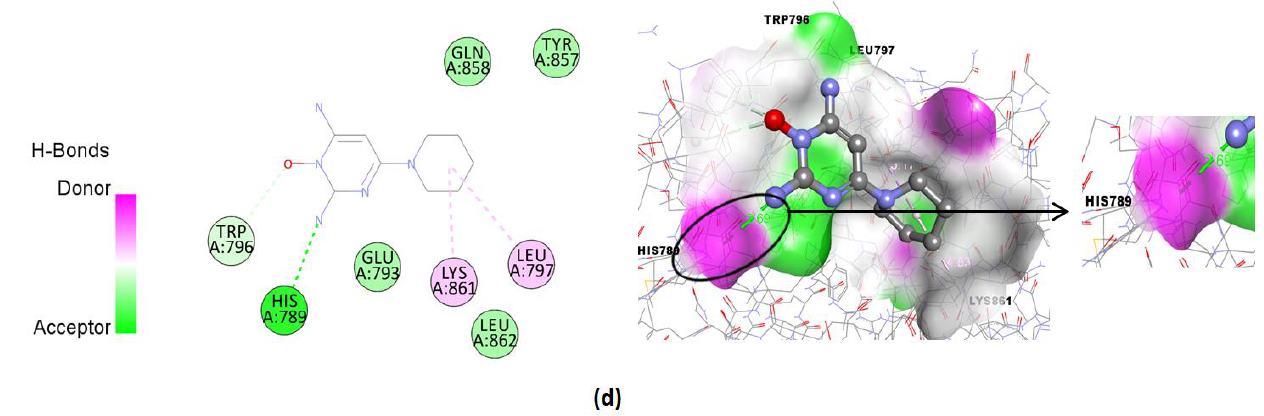
Figure 8. Visualization of amino acid interaction and H-bond surface between the androgen receptor and ( a ) Compound 2 , ( b ) Compound 3 , ( c ) Compound 4 , and ( d ) Minoxidil (standard).